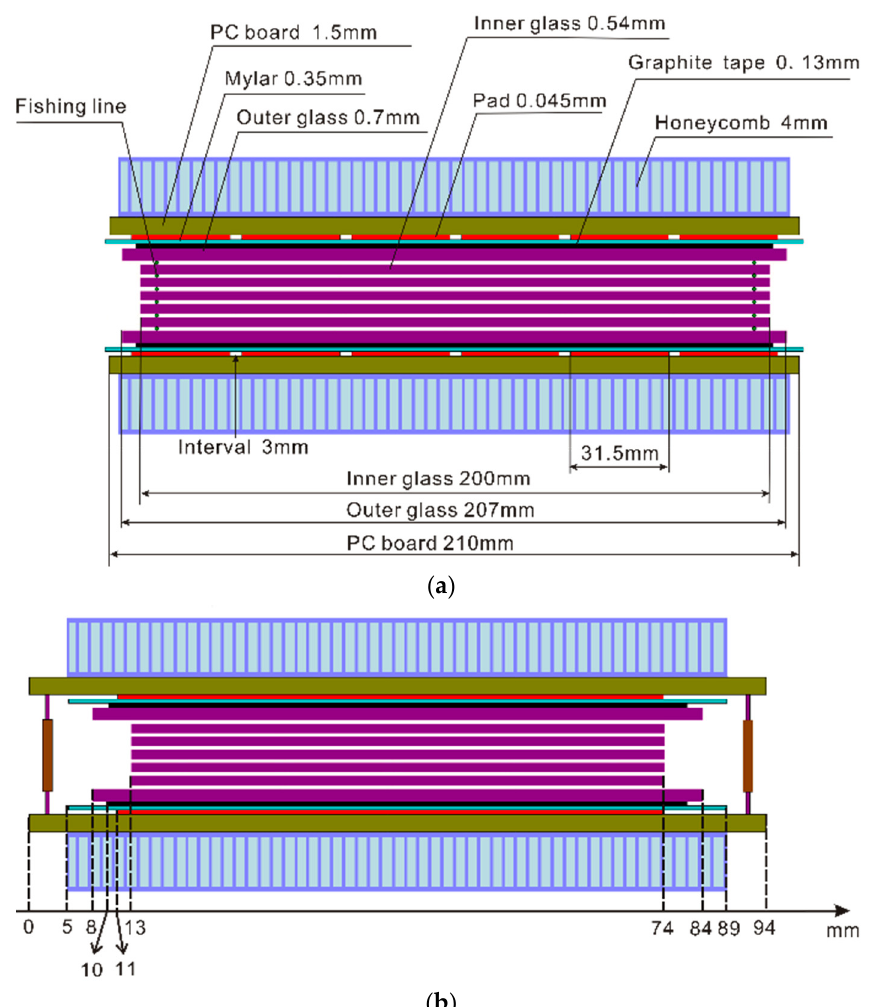
Figure 2. The structure of the STAR MRPC detector. ( a ) shows the long side view, while ( b ) shows the short side. threshold (ToT) values instead of the signal amplitude for earlier runs. The time resolutions of the final system trays are below 80 ps, which meets the physics requirement.